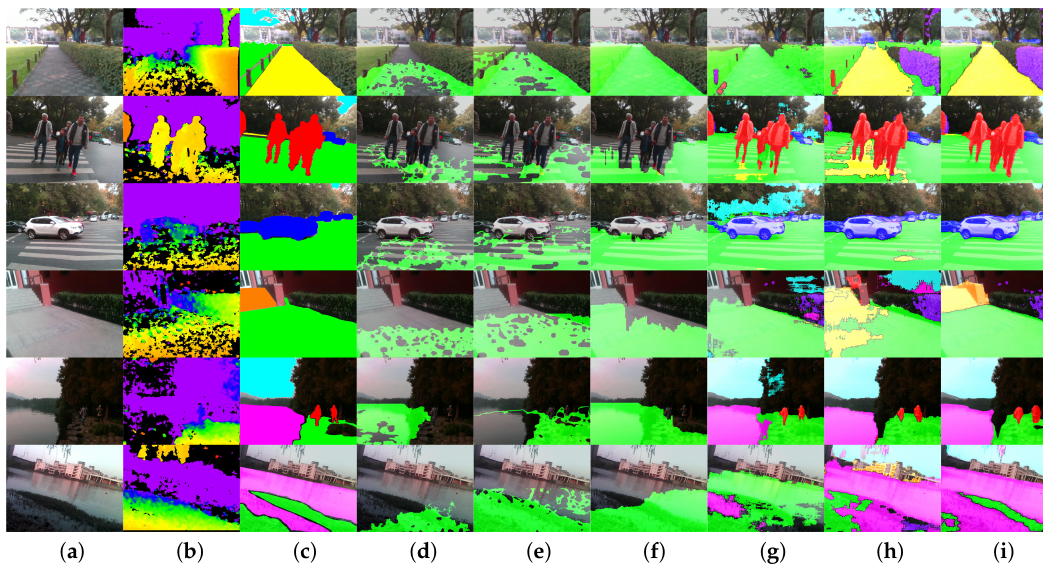
Qualitative examples of the segmentation on real-world images produced by our approach compared with ground-truth annotation, 3D-SeededRegionGrowing [20], 3D-RANSAC-F [9], FreeSpaceParse [25], ENet [61] and LinkNet [67]. From left to right: ( a ) RGB image, ( b ) depth image, ( c ) annotation, ( d ) 3D-SeededRegionGrowing, ( e ) 3D-RANSAC-F, ( f ) FreeSpaceParse, ( g ) ENet, ( h ) LinkNet and ( i ) our